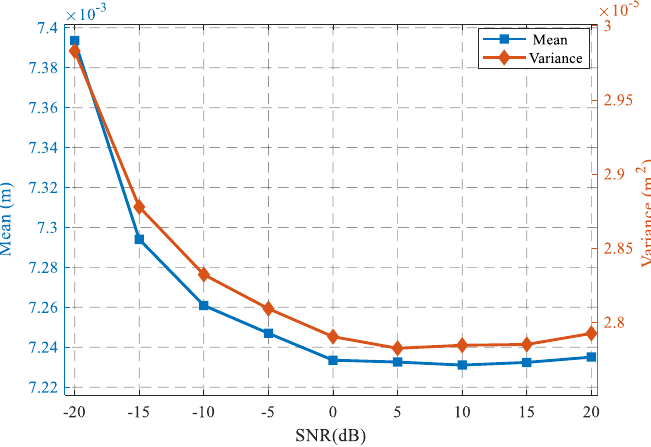
Figure 4. Mean and variance of observation noise versus different